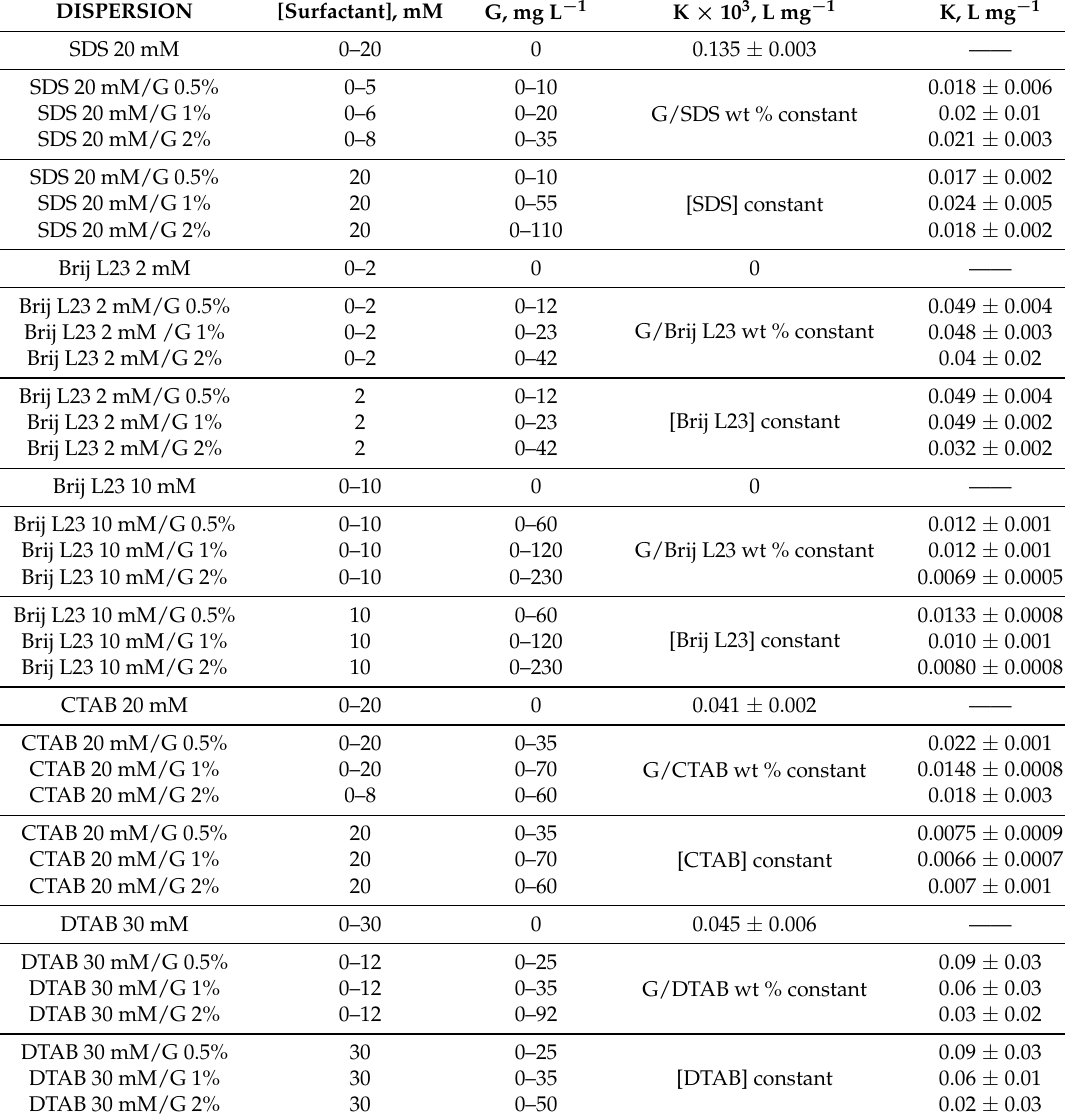
Table 2. Quenching constants (K) obtained from the plots F 0 /F vs. G concentration for G (0.5, 1 and 2 wt %) dispersions in the different surfactants in the linear concentration range with intercept